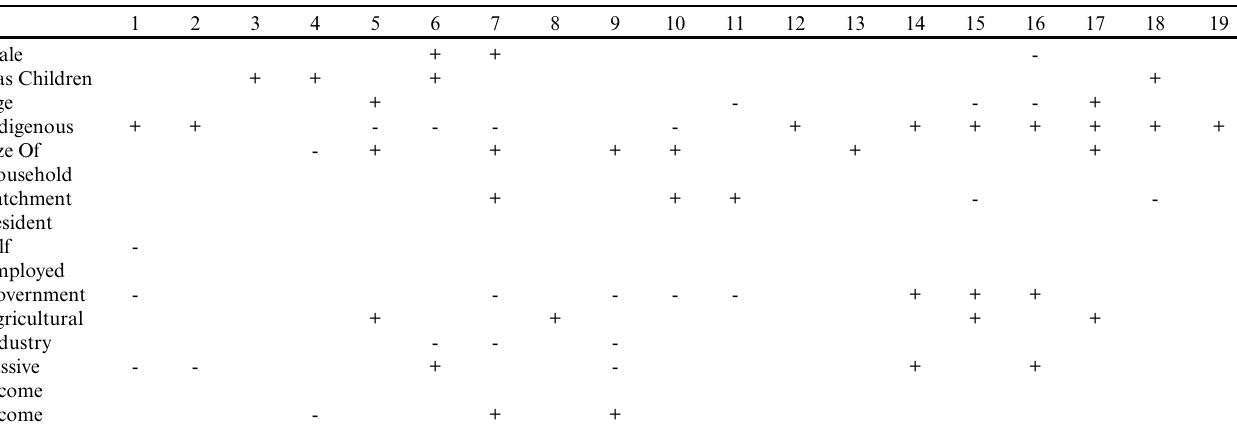
Table 4 . Characteristics of respondents (n = 141) determining the importance of the 19 factors tested. Characteristics included in the best explanatory model of importance factors for each factor are displayed by plus or minus, indicating that the variable had a positive or negative relationship, respectively, with the perceived importance of the factor.